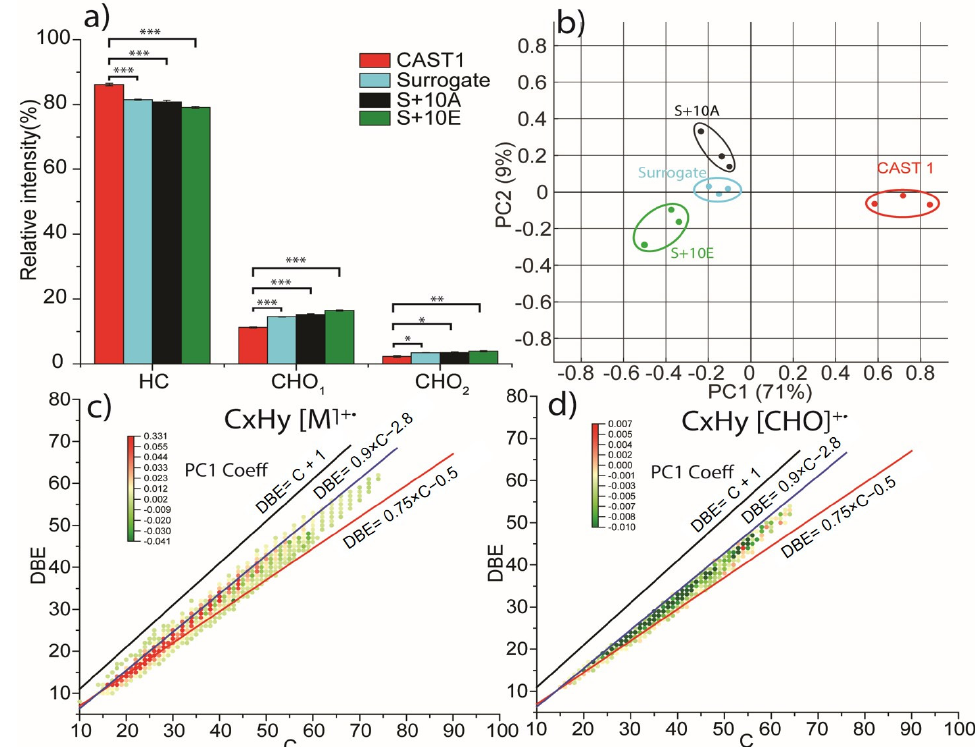
Figure 2. ( a ), Ion relative intensity for hydrocarbons and compounds with carbon, hydrogen, and one or two oxygen atoms (CHO 1–2 ) for CAST1 and Surrogate fuels (n = 3). T -test p -values are reported —between CAST 1 and Surrogate fuels as: * for p < 0.05, ** for p < 0.01, *** for p < 0.001; ( b ) principal component analysis score plot from the list of intensities of molecular formulas c), double bond equivalent (DBE) vs. carbon number diagram for hydrocarbon radical ions color-coded using PC1 coefficient and d), double bond equivalent vs. carbon number for radical ions with one oxygen atom color-coded using PC1 coefficient. For both diagrams ( c ) and ( d ), the lines represent the trend of DBE vs. carbon number for the cata-condensed polycyclic aromatic hydrocarbons (PAHs) (in red), peri-condensed PAHs (in blue), and elemental carbon (in black) structures.